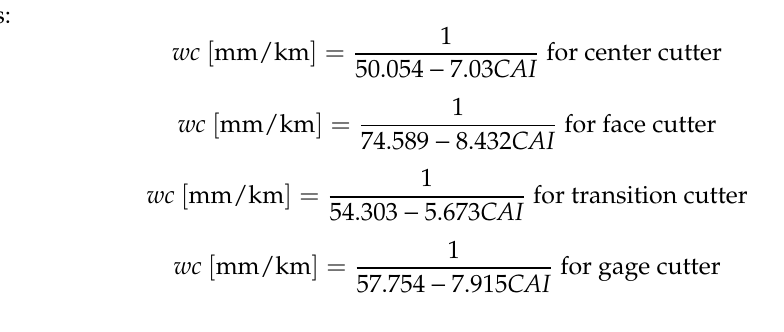
Figure 11. Relationship between the CAI values and the wear coefficient.